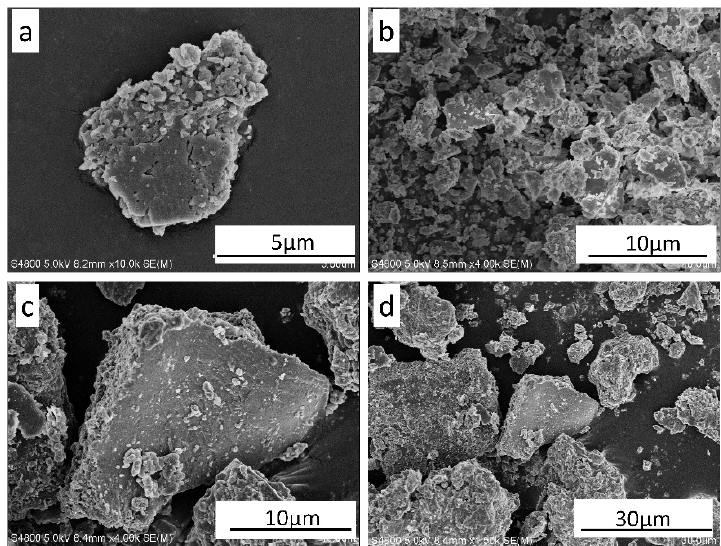
Figure 8. The SEM of kaolin clay and PAC-MC. Kaolin clay ( a , b ), PAC-MCB ( c , d ).